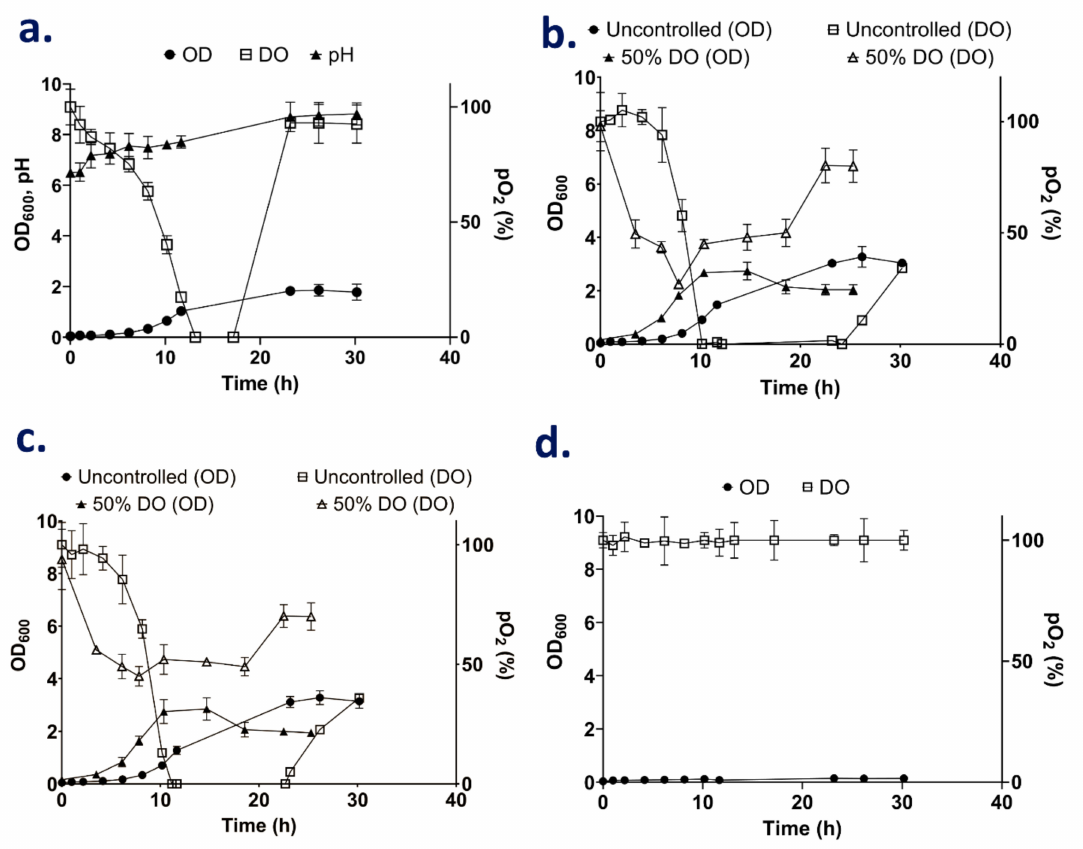
Figure 1. Fermentation profiles of SOS3 batch cultures in Biostat A bioreactors. ( a ) Reference fermentation; no pH control;